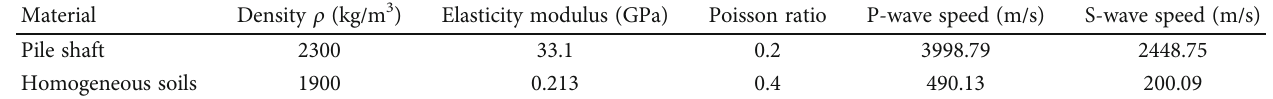
Table 1: Pile-soil parameters.